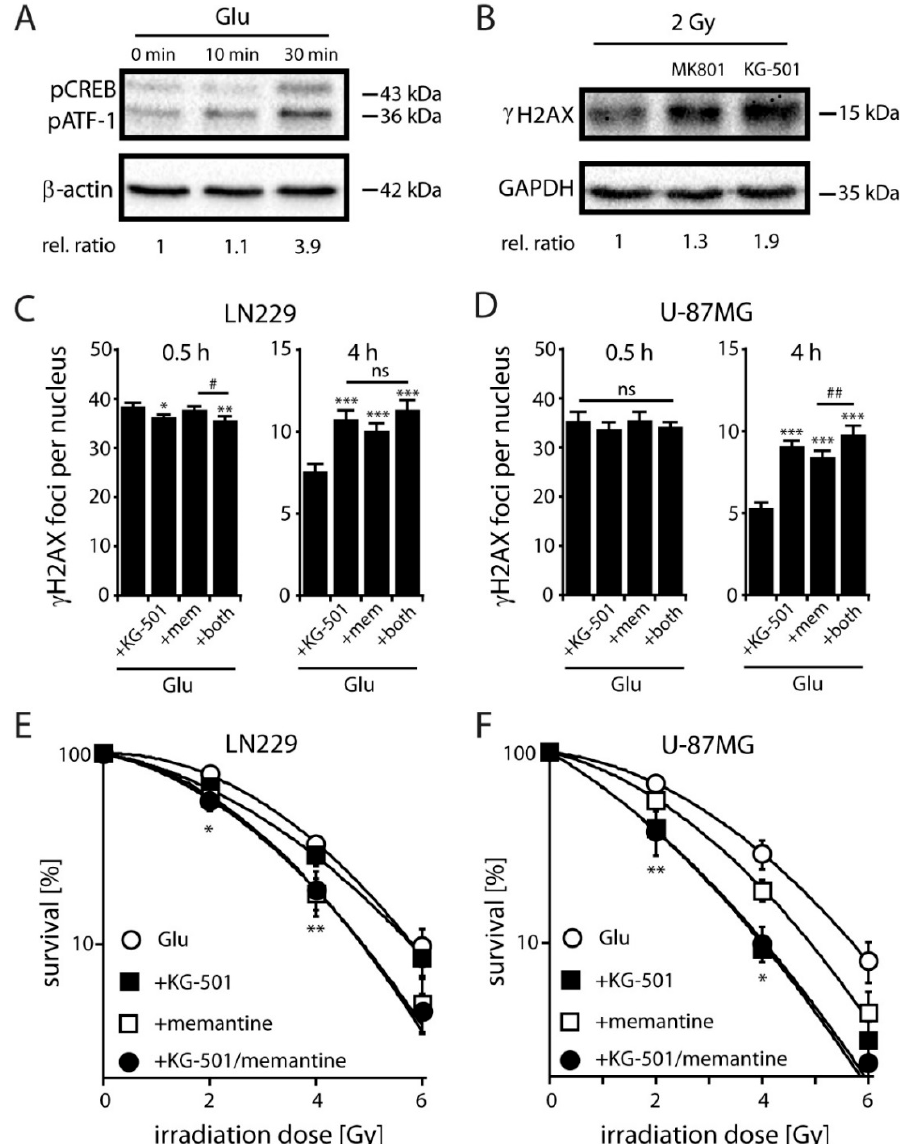
Figure 4. Effects of glutamate-induced pCREB on DNA repair and clonogenic survival in glioblastoma cells. ( A ) Relative pCREB levels in LN229 cells detected by western blotting (normalized to β -actin) at the indicated time points after treatment with Glu (1 mM). Note that the pCREB antibody is also detecting pATF-1, a protein closely related in structure and function to CREB (relative ratio at 30 min: 3.7 ± 1.1, p < 0.05; n = 3; Student’s t-test). ( B ) γ H2AX protein levels and their relative ratio (normalized to GAPDH expression) in the presence of Glu (1 mM) and MK801 (10 µM) or KG-501 (25 µM) 4h after IR with a dose of 2 Gy detected by western blotting. Relative ratio for MK801 treatment is 1.4 ± 0.3 (ns; n = 3; Student’s t-test) and for KG-501 1.8 ± 0.4 ( p < 0.05; n = 3; Student’s t-test). ( C ) γ H2AX foci detection in EdU-negative non-S-phase LN229 cells at 0.5 h and 4 h following 2 Gy exposure after treatment with Glu (1 mM) and with Glu in the presence of KG-501 (25 µM), memantine (mem, 100 µM) and both inhibitors. Data represent means ± SEM of γ H2AX foci of three independent experiments. Data were analyzed by one-way ANOVA followed by Bonferroni´s post-hoc test. * indicates significant difference between Glu-treated control and Glu in the presence of the antagonists, # indicates significant difference between the different antagonists (* /# p < 0.05, ** p < 0.01, *** p < 0.001). ( D ) γ H2AX foci detection in EdU-negative non-S-phase U-87MG cells at 0.5 h and 4 h following 2 Gy exposure after treatment with Glu (1 mM) and with Glu in the presence of KG-501 (25 µM), memantine (mem, 100 µM) and both inhibitors. Data represent means ± SEM of γ H2AX foci of three independent experiments. Data analyses see Figure legend 4C ( ## p < 0.01 *** p < 0.001). ( E ) Clonogenic survival of LN229 cells treated with 1 mM Glu in the absence and presence of KG-501 (1